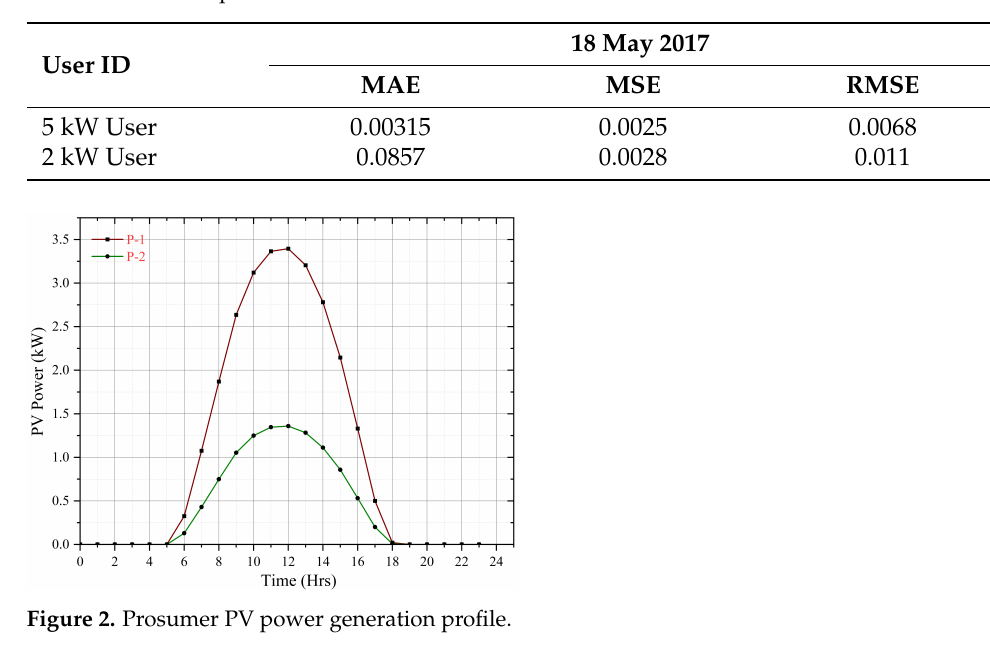
Table 4. Prediction performance measures on PV forecast error data.